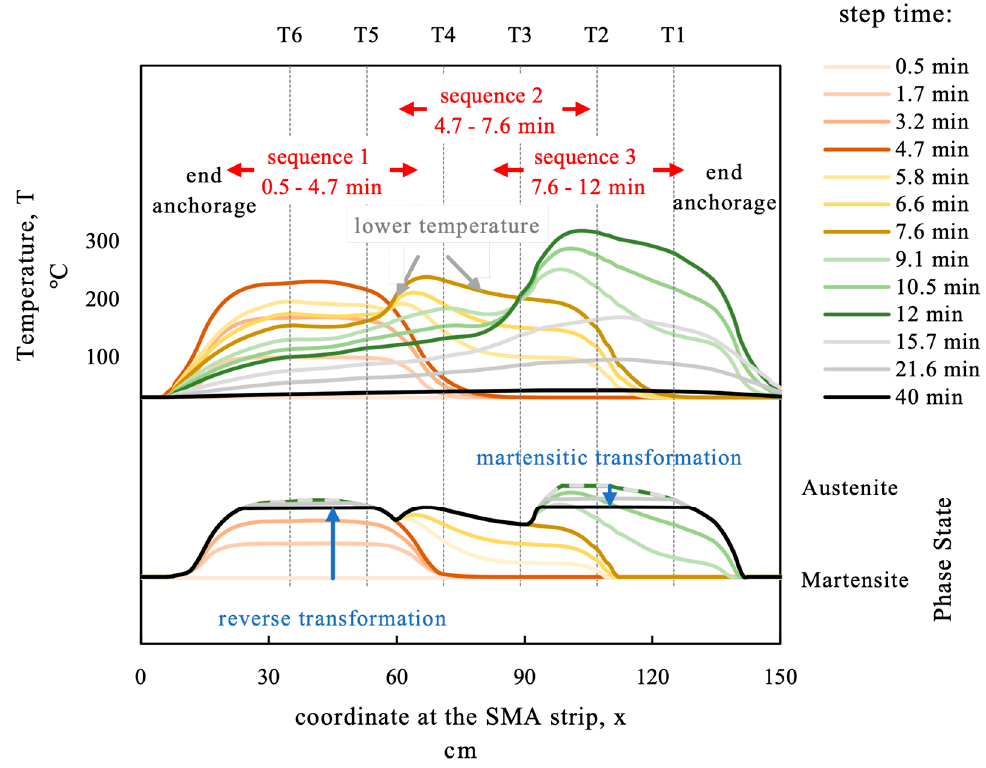
Figure 16. Comparison of the measured temperature and the modeled temperature.